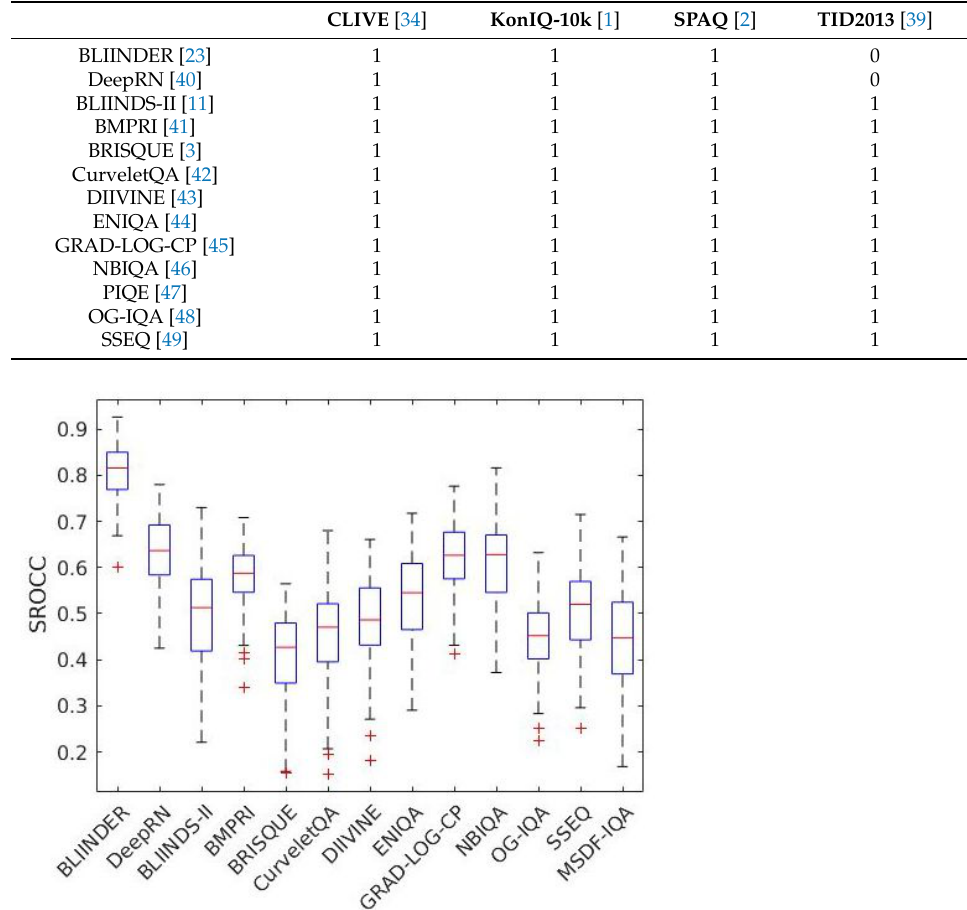
Table 10. One-sided t-test. Symbol ’1’ means that the proposed MSDF-IQA method is statistically better than the NR-IQA method in the row on the IQA benchmark database in the column, while symbol ’0’ means that the proposed MSDF-IQA performs significantly worse. Symbol ’-’ is used when there is no significant difference.